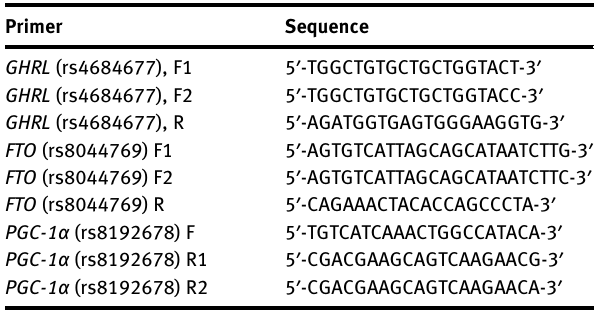
Table  : Primer sequences for PCR ampli fi cation of GHRL, FTO, and PGC-  α